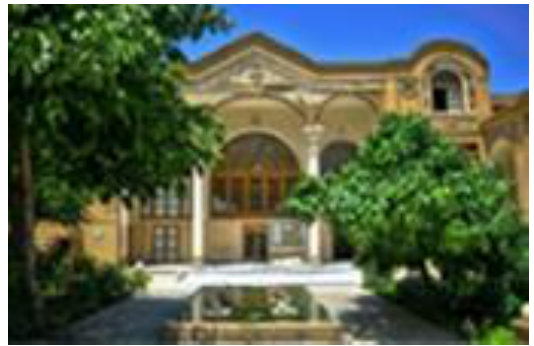
Figure 2 Courtyard house No.1 (Source: Iran Cultural Heritage, Handicrafts and Tourism Organization)